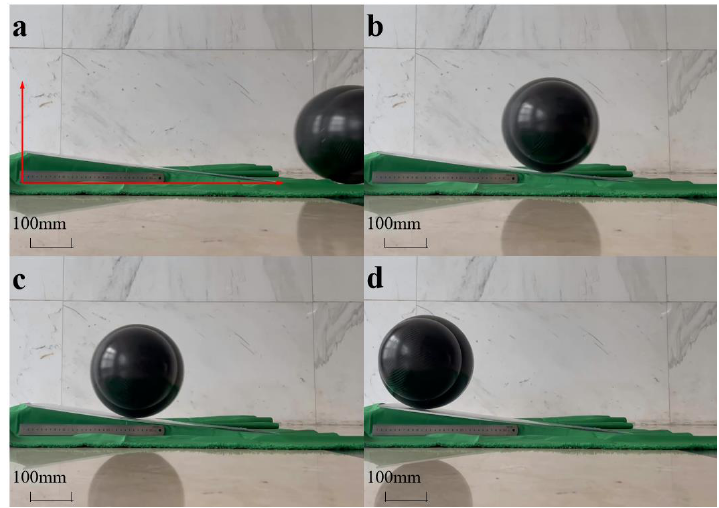
Figure 18. Climbing motion of the robot.